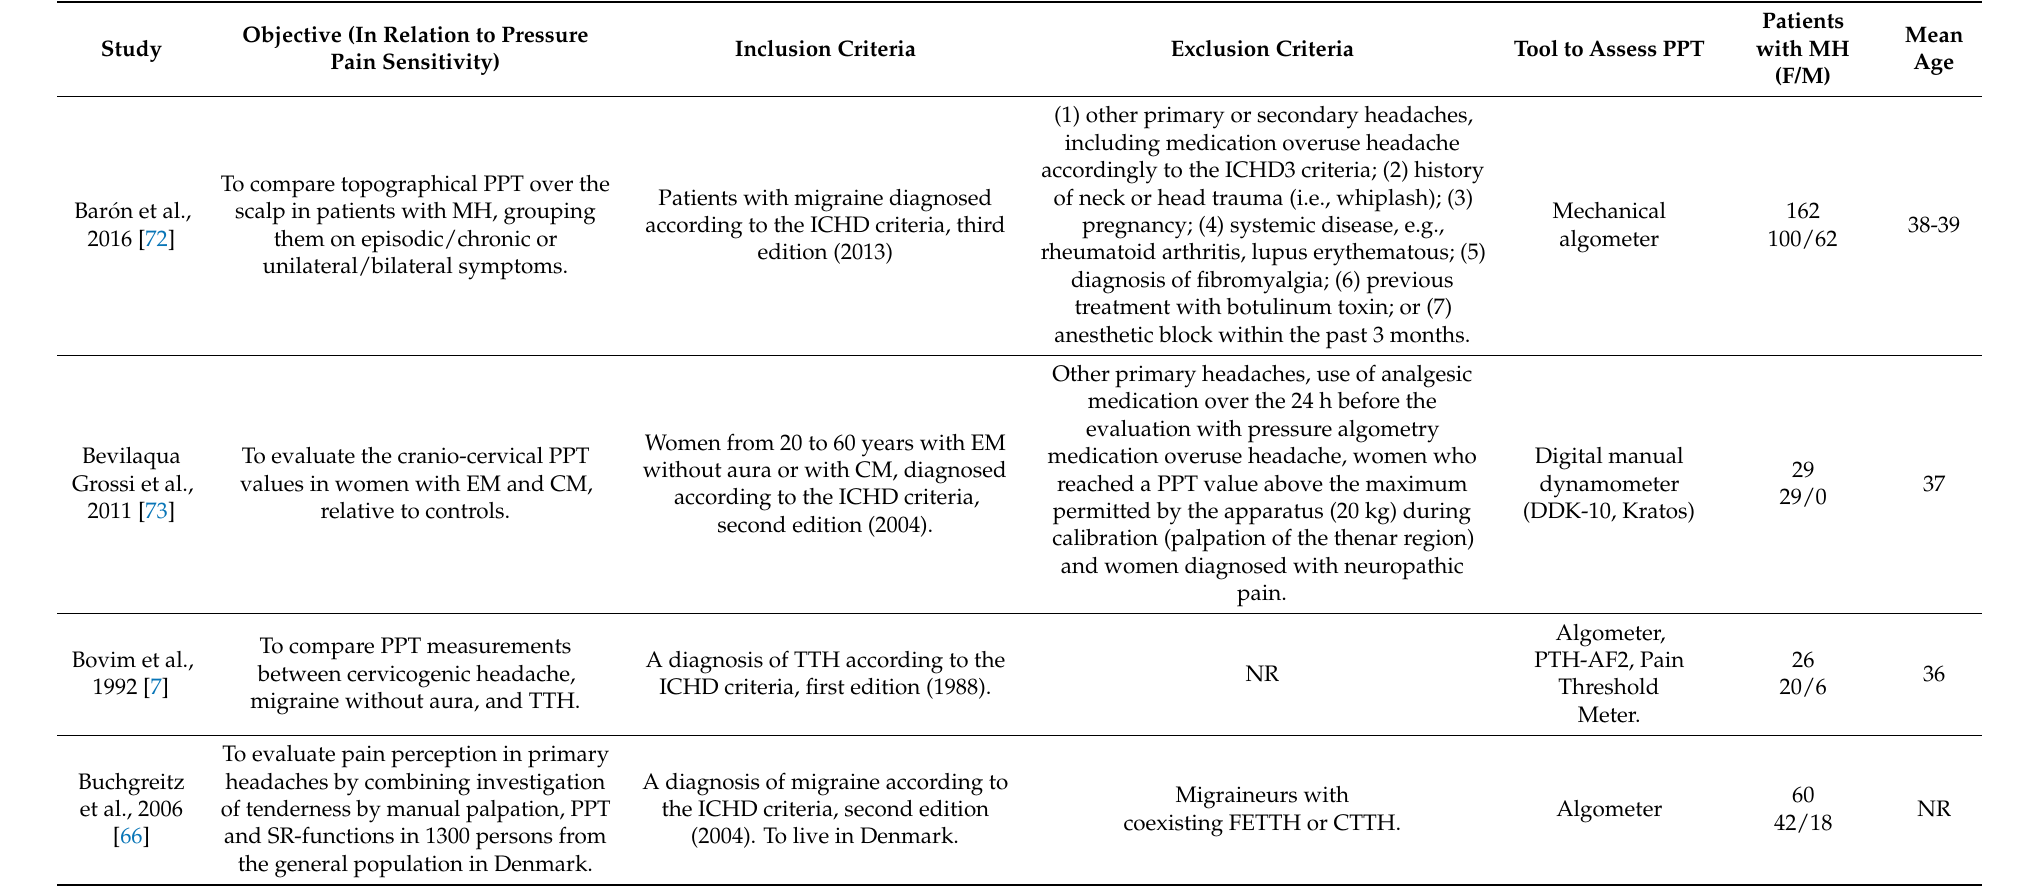
Table 4. Characteristics of studies including women with